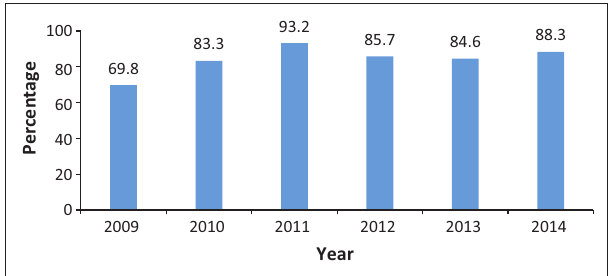
FIGURE 3: Banking sector average cost efficiency